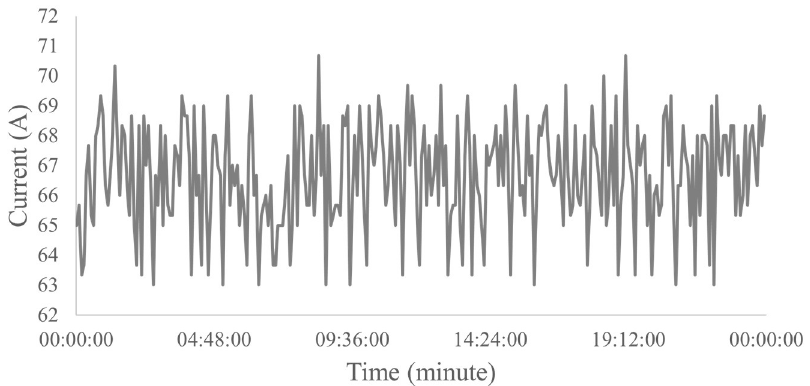
Figure 7. Example of a real well with gas interference for 24 h.